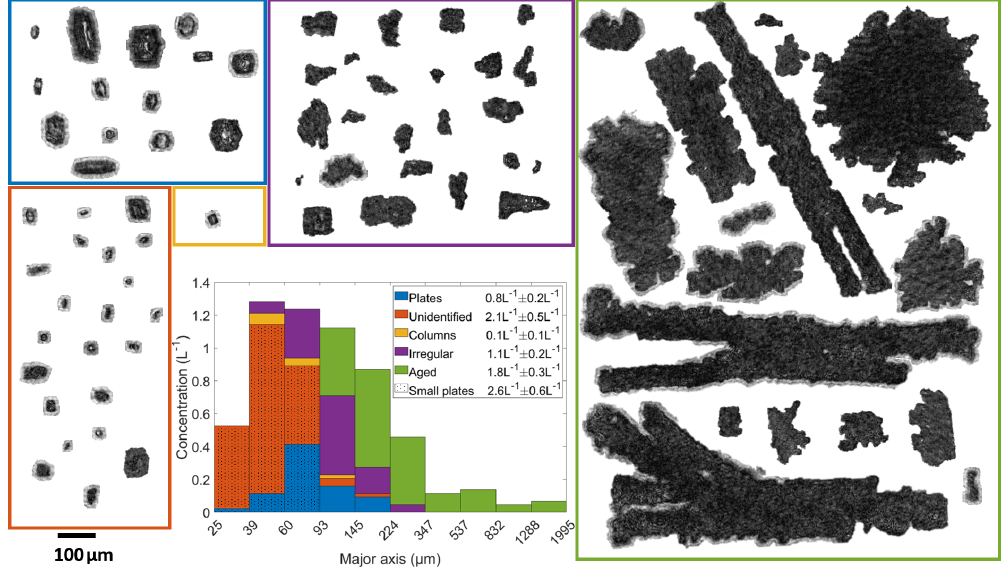
Figure 5. The figure shows a randomly selected sample of ice crystals, which were observed in the cloud together with a stacked size distribution of the different habits. The total concentrations together with the uncertainties in each habit are shown in the legend of the histogram. Unidentified crystals as well as plates smaller than 93µm in their major axis are referred to as “small plates” as discussed (see text for more details).